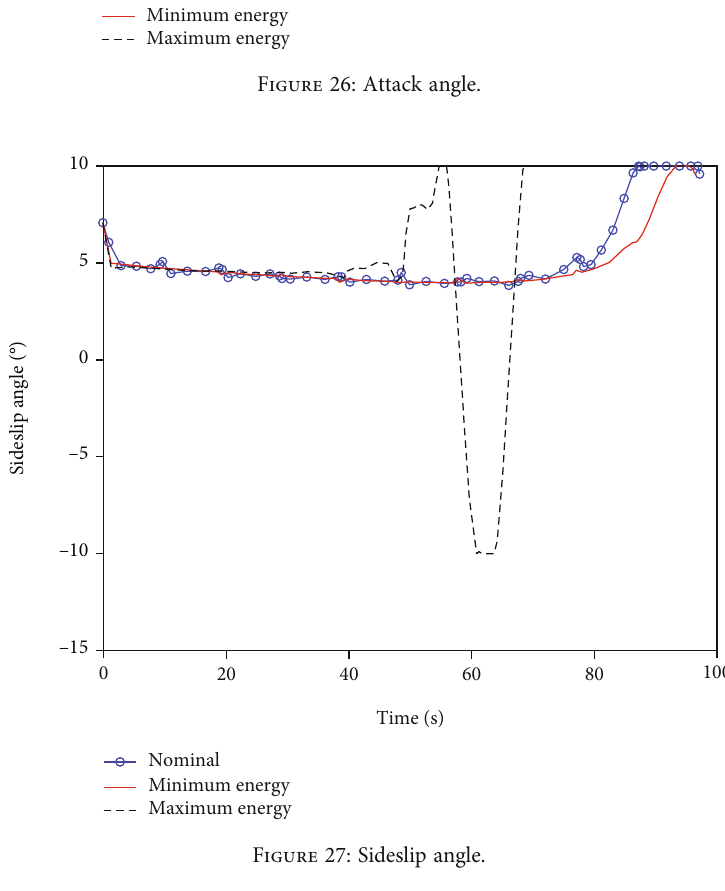
Figure 27: Sideslip